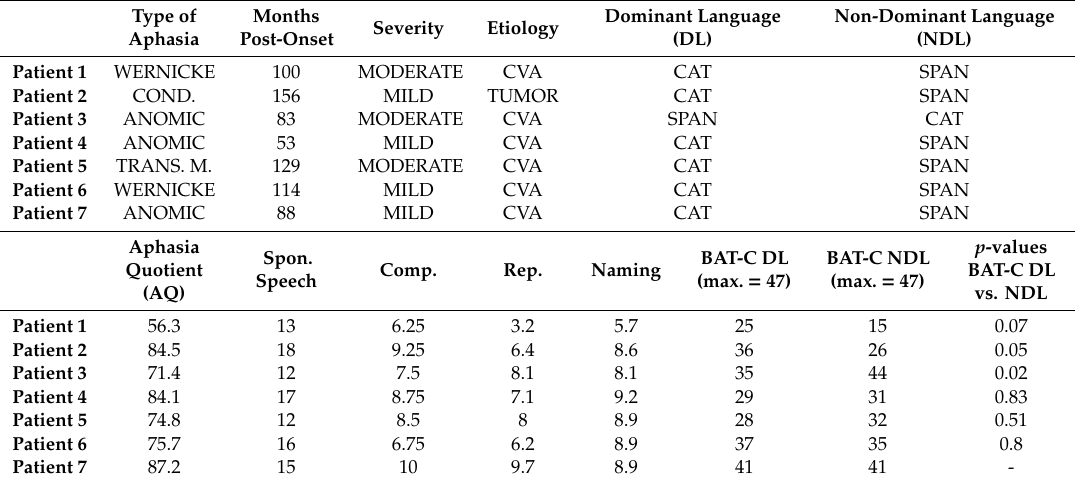
Table 3. Individual clinical and linguistic data for bilinguals with aphasia